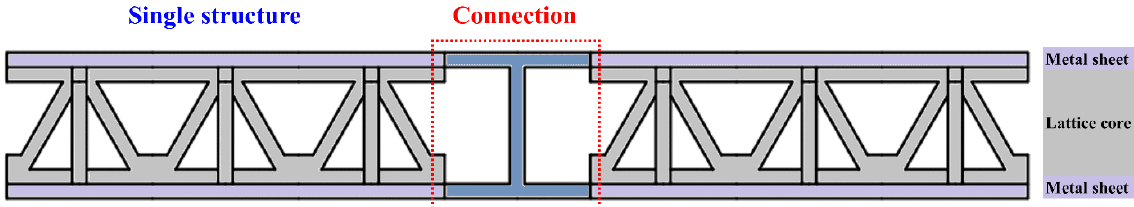
Figure 1. Schematic of panel-to-panel construction.